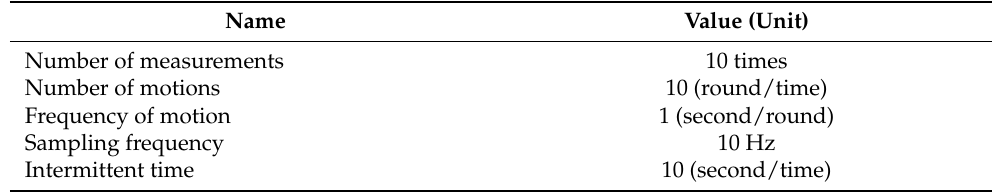
Table 1. Measured parameters in the ROMSS with the simulated arm.